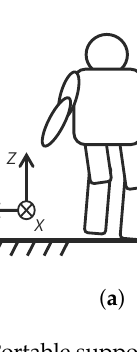
Figure 3. Portable support object. ( a ) support object #4: cane (line-segment shape); and, ( b ) definition of moving coordinate system O − x C y C z C and angles α and β . Table 1. Support objects considered in this